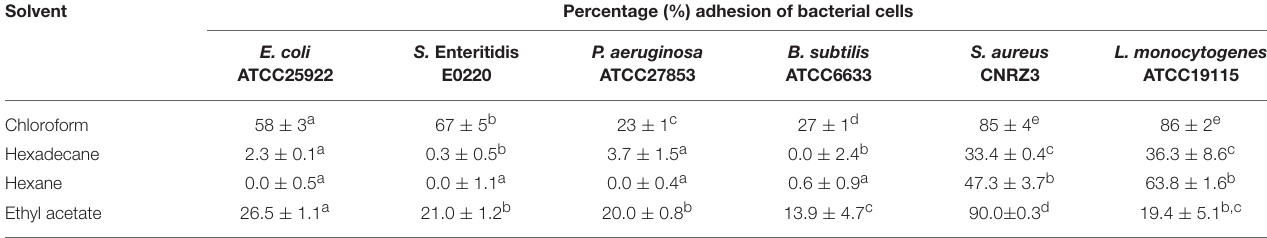
TABLE 6 | Adhesion of bacterial cells to solvent-water interfaces ( n = 3).